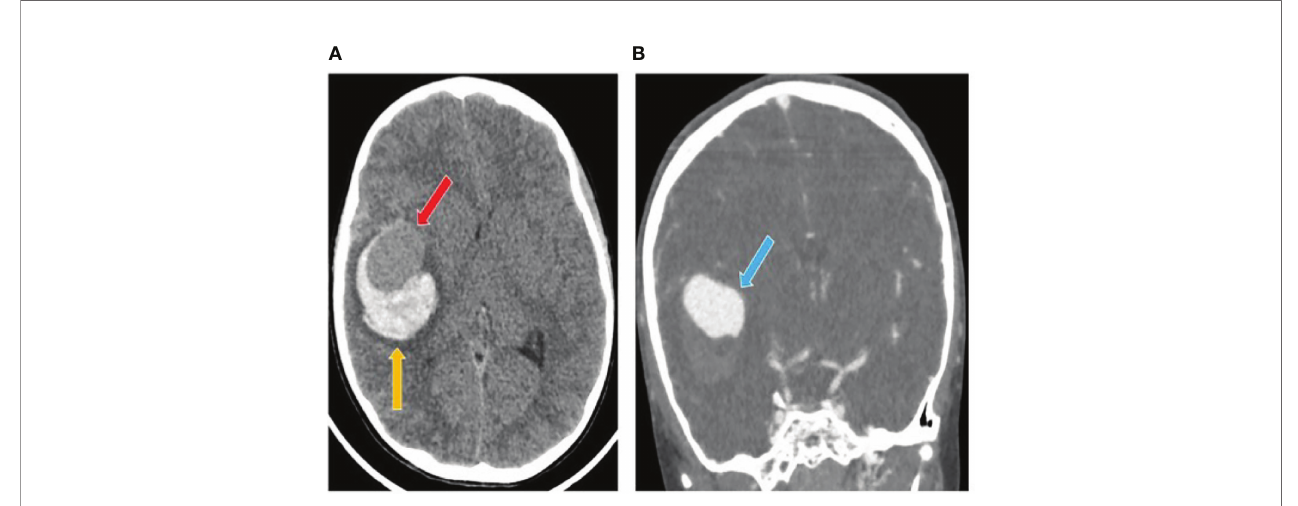
FIGURE 1 | Computed tomography (CT) scan after intracranial aneurysm rupture. (A) The initial head CT showed a thin subarachnoid hemorrhage and a large intra- parenchymal hemorrhage (yellow arrow) including an iso-dense region (red arrow). (B) The angio-TC showed a cerebral aneurysm originating from the right middle cerebral artery (blue